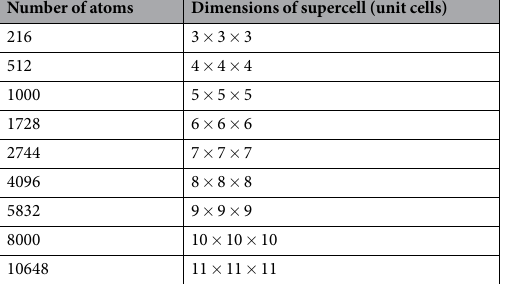
Table 2. A list of the supercells that have been studied in this work, showing the number of atoms in each supercell and the real space dimensions of each of the cells (in units of simple-cubic unit cells). The dimensions of each simple-cubic unit cell are 0.546 nm × 0.546 nm × 0.546